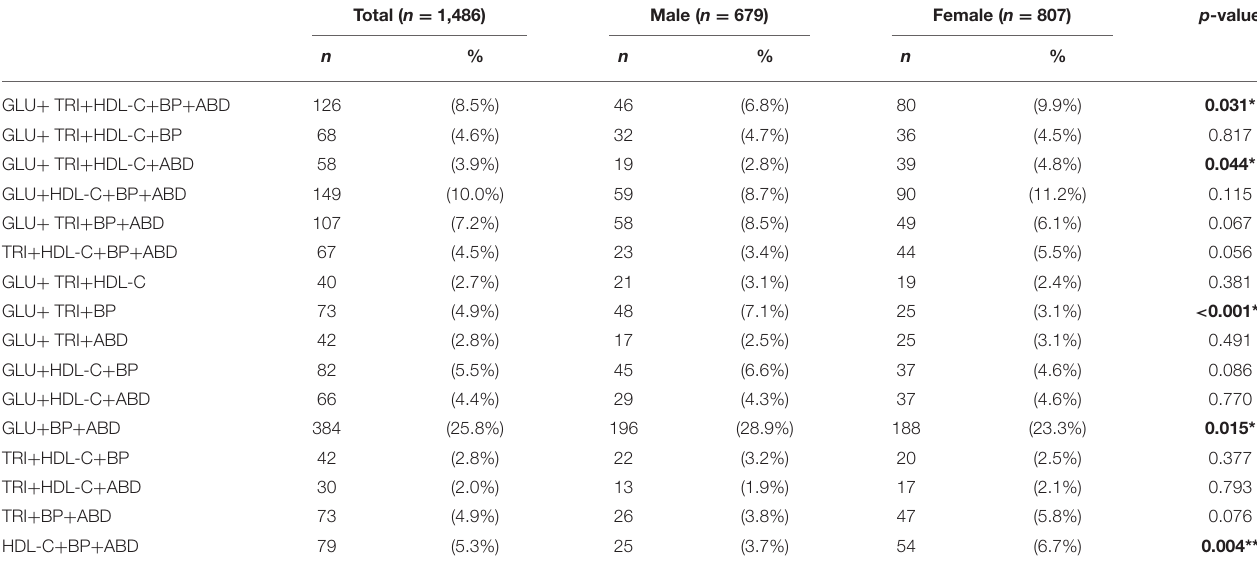
TABLE 2 | Prevalence of metabolic syndrome component combinations in participants with metabolic syndrome in